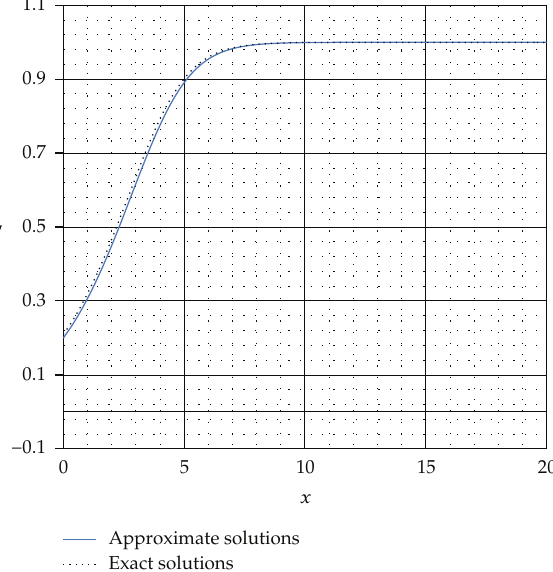
Figure 2: The graph of log